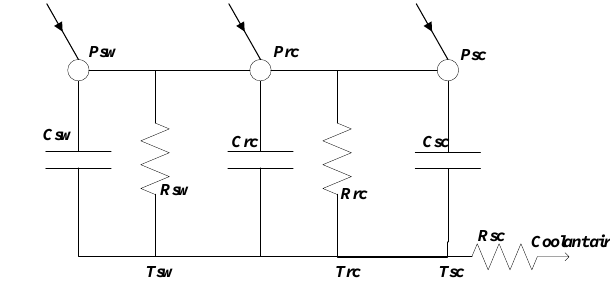
Figure 1. The thermal network of the